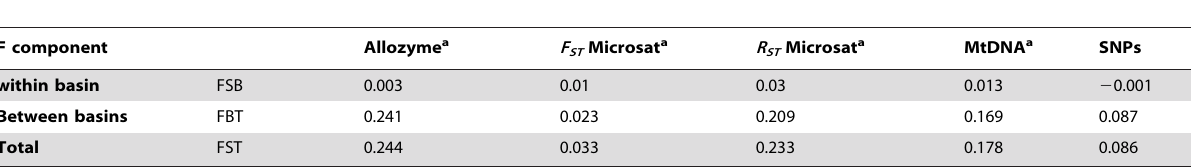
Table 6. Locus by locus AMOVA of SNPS compared to allozyme, microsatellite and mtDNA.